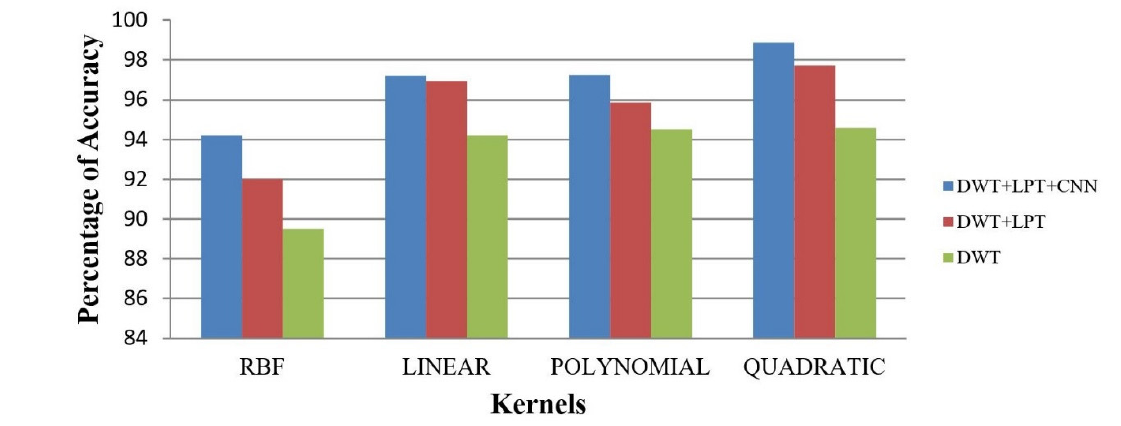
Figure 14. Average Accuracy for Abnormality Detection of T-2 weighted images.